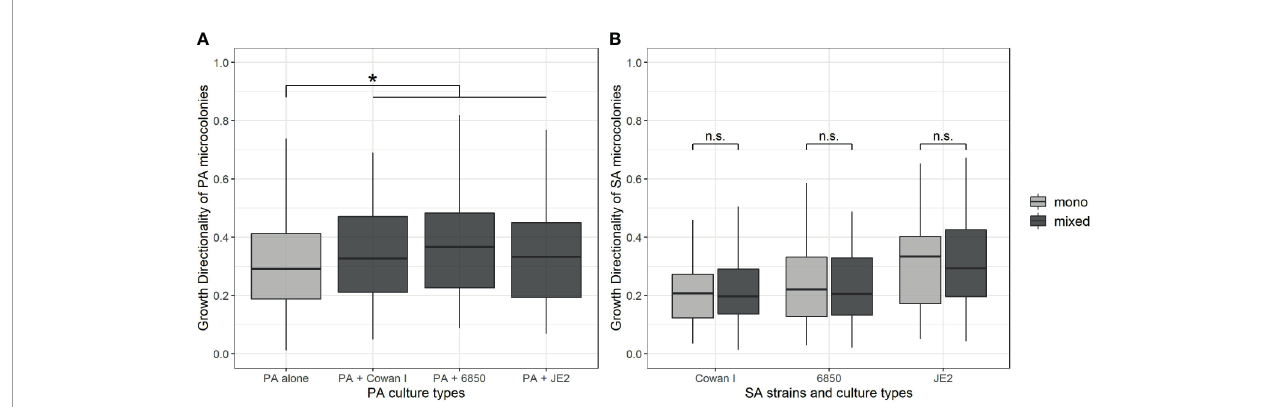
FIGURE 3 | Directionality of microcolony growth of P. aeruginosa (PA) and S. aureus (SA) in monoculture (light-grey) and mixed culture (dark-grey). We calculated the directionality of growth as D e /D a (where D e is the euclidean and D a is the accumulated distance, respectively). The closer this ratio is to 1.0, the more directional the movement of a microcolony is. (A) Growth directionality of PA microcolonies is signi fi cantly increased in the presence of SA. (B) Growth directionality of SA microcolonies is not affected by the presence of PA for none of the SA strains. The box plots show the median (bold line) with the fi rst and the third quartiles. The whiskers cover the 1.5* inter-quartile range (IQR) or extend from the lowest to the highest value if they fall within the 1.5* IQR. *p < 0.05, n.s., not signi fi cant. Data is from three independent experiments per PA-SA combination, with a total of 352 and 323 microcolonies for PA and SA strains, respectively.